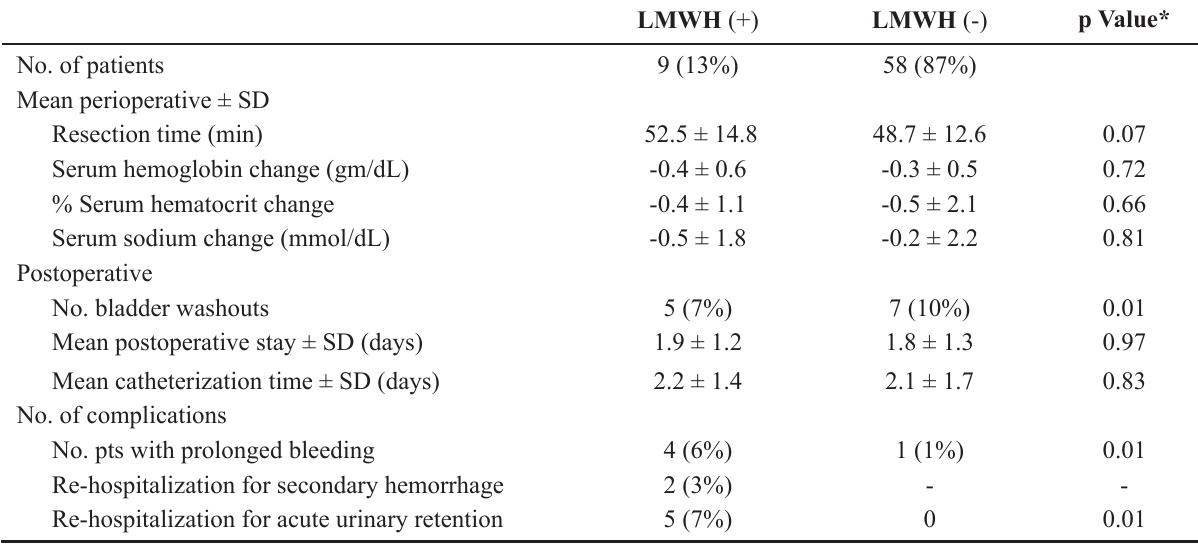
Table 3 – Perioperative and postoperative outcomes and follow-up results (LMWH (+) the patients who had low molecular weight heparin before the PVP surgery and LMWH (-) those who did not.)